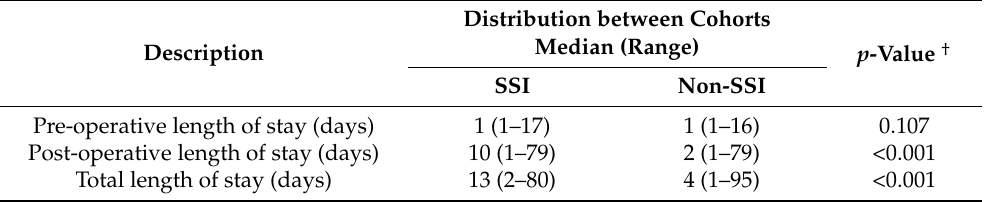
Table 3. Impact of SSIs on patients’ length of hospitalization (LOS).